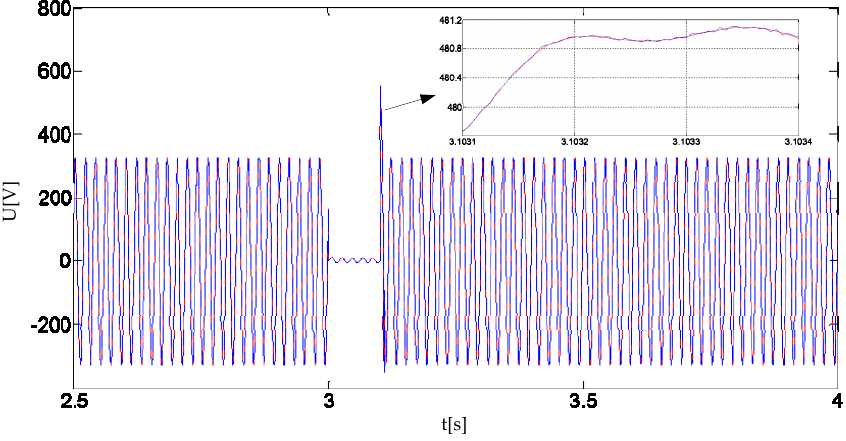
Figure 8. The three-phase voltage waveform of node 8.